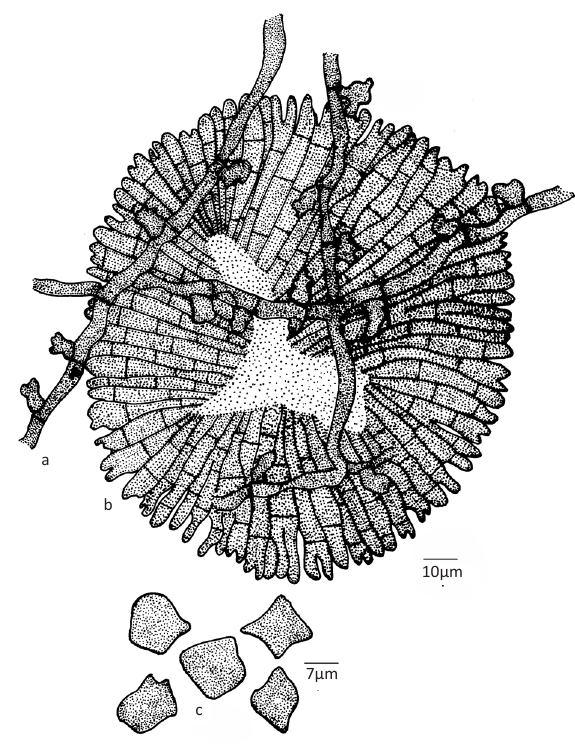
Figure 12. Mahanteshamyces litseae sp. nov. a - Appressoriate mycelium; b - Pycnothyrium; c - Pycnothyriospores